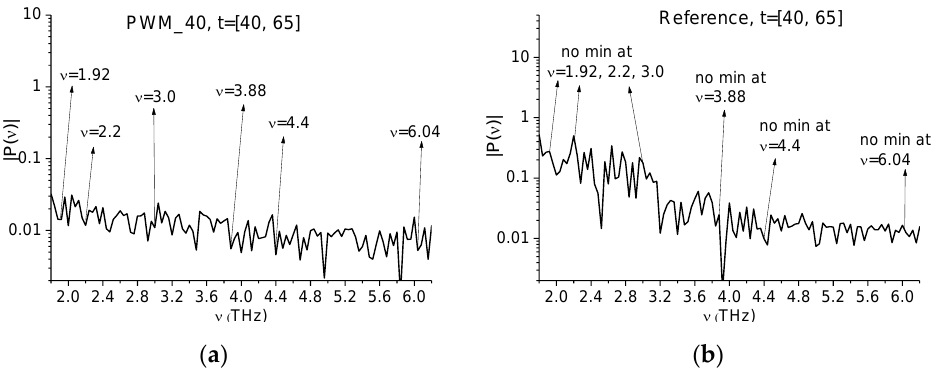
Figure 13. Fourier spectra of the PWM_40 first sub-pulse ( a ) and reference ( b ) in the frequency range ν = [1.8, 6.2] THz in the logarithmic scale along the abscissa axis.